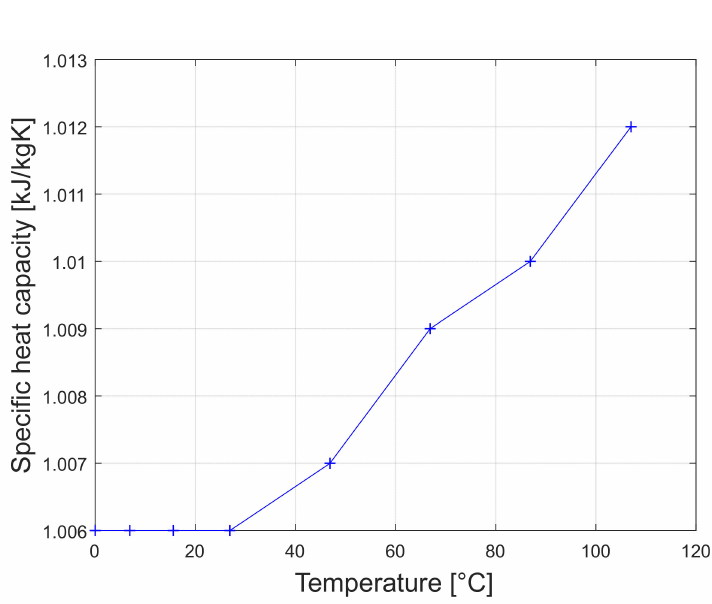
Figure 7. Temperature dependence of the specific heat capacity of air, using the data obtained from [35].